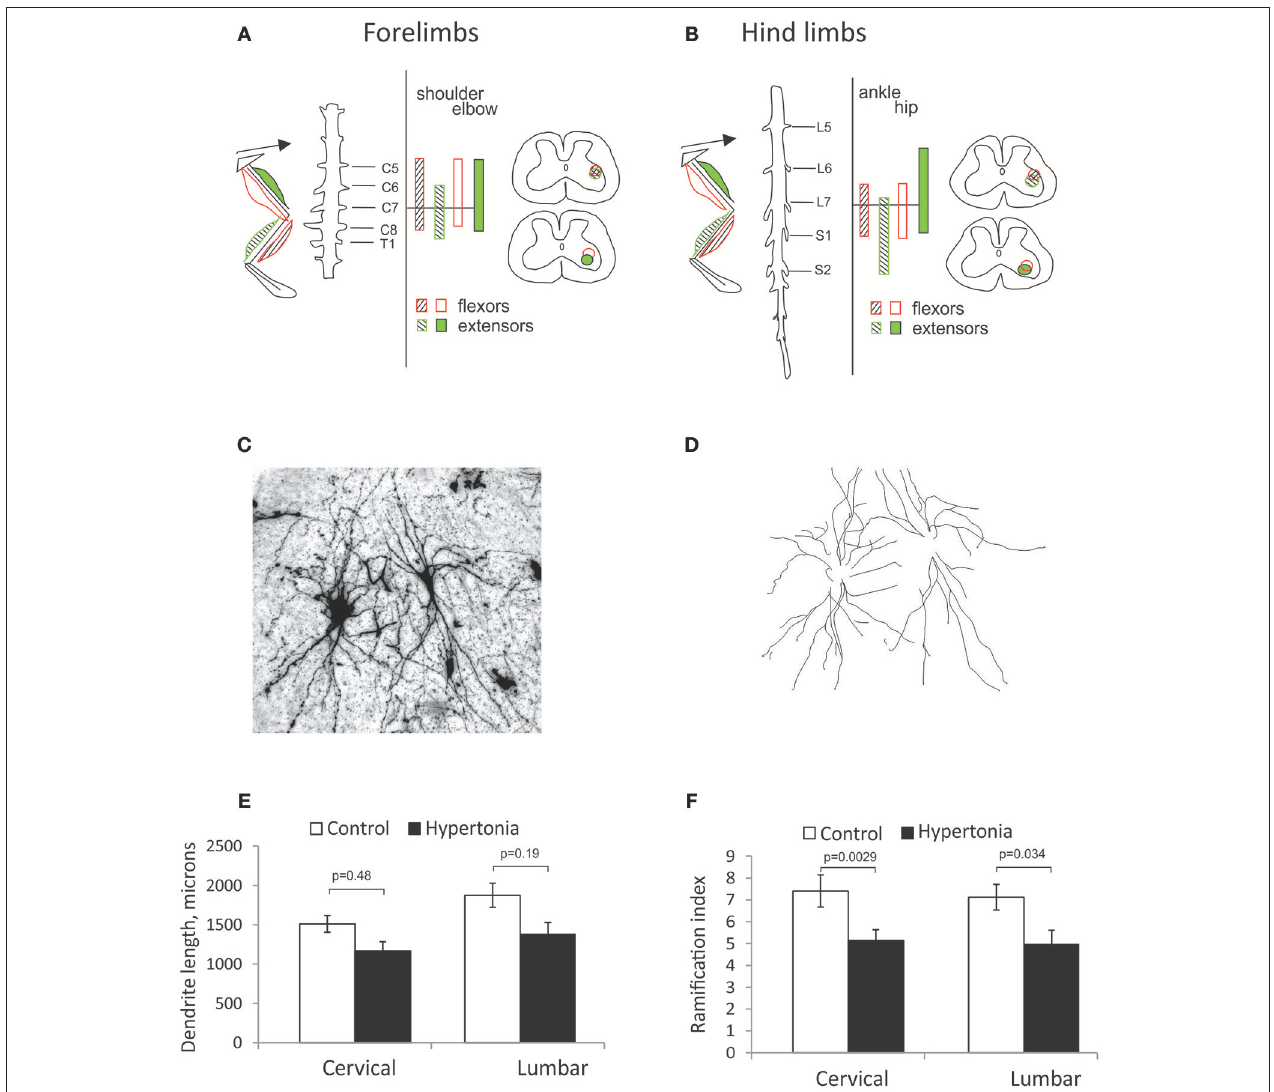
FIGURE 5 | Somatotopic motoneuron mapping and dendritic tree sizes in motor neurons on Golgi staining. (A,B) Location of cholera toxin retrograde labeled neurons from distal and proximal muscle groups on spinal cord cross-sections in cervical (A) and lumbar expansions (B) . Location of motor neurons projecting to distal and proximal (wrist and elbow in forelimbs, ankle, and knee in hind limbs) muscles were indicated as hatched and filled circles, correspondingly, flexor, and extensor muscles—in empty and filled circles, correspondingly. Golgi stained motor neurons were photographed at 10x magnification as a stack and maximum intensity projection obtained (C) . Individual neurons were traced (D) . Sholl analysis was conducted to estimate length of dendritic tree (E) and ramification index (F)